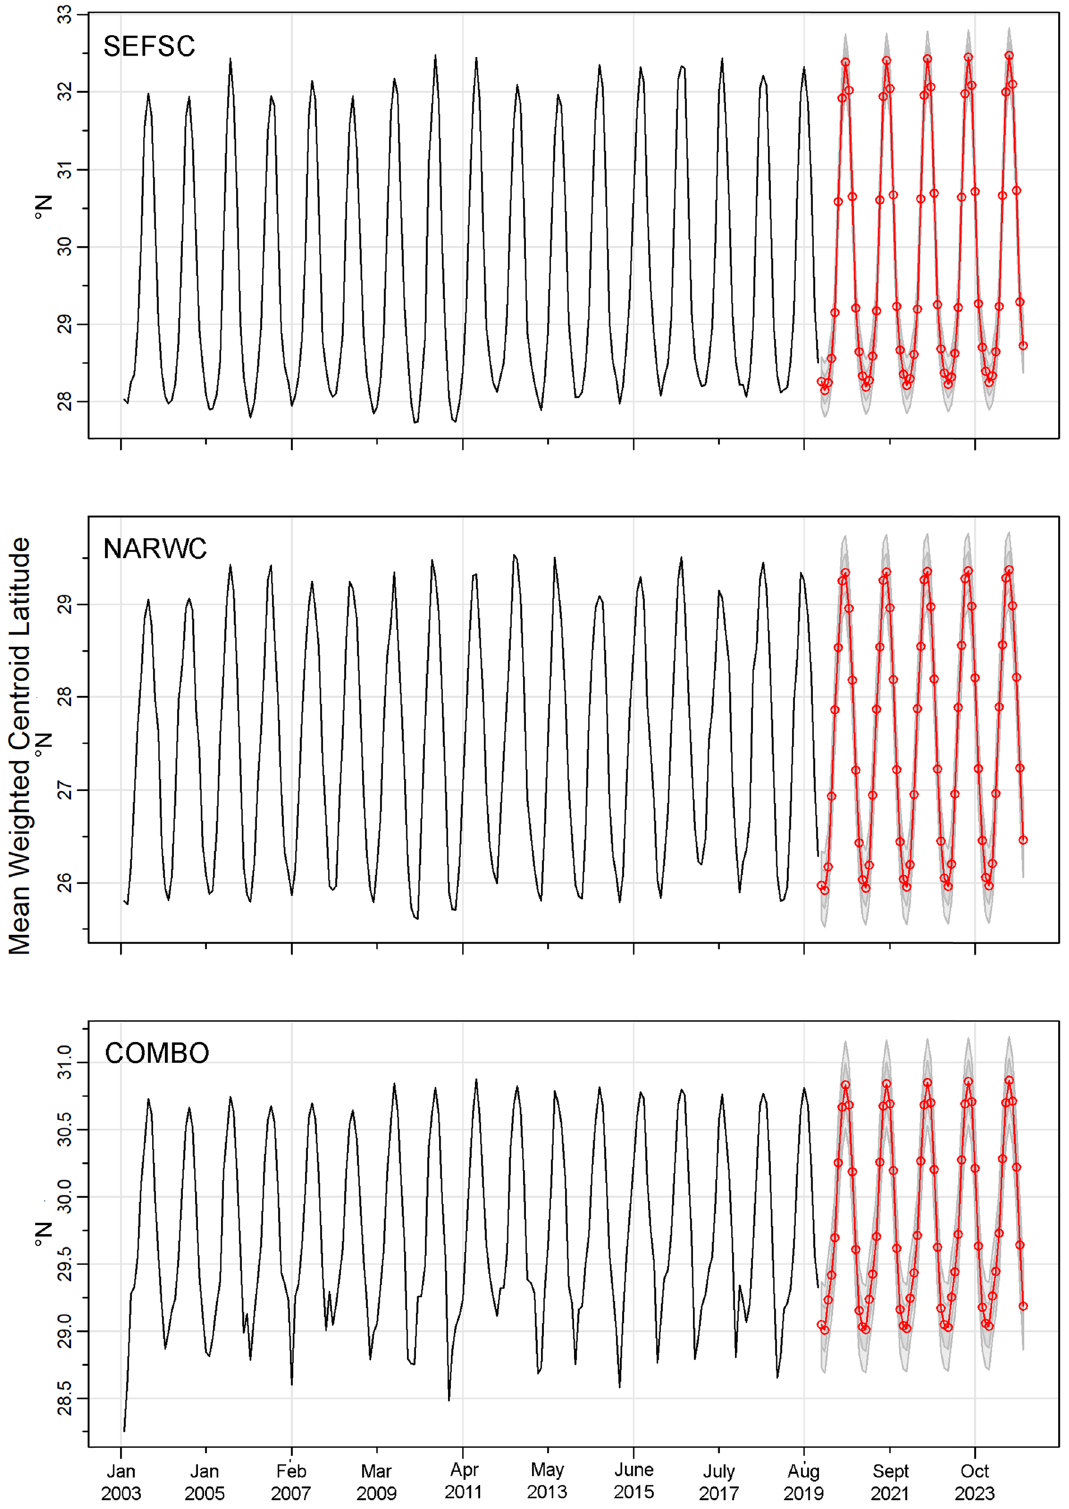
Figure 8. Time-series of predicted mean weighted latitudinal centroid for best-fitting manta ray species distribution models generated from SEFSC, NARWC, and combined surveys (“COMBO”) from January 2003 to December 2019 with seasonal auto-regressive integrated moving average (SARIMA) mean (red) and ± 1 and ± 2 standard error (gray) forecasts for January 2020 to December